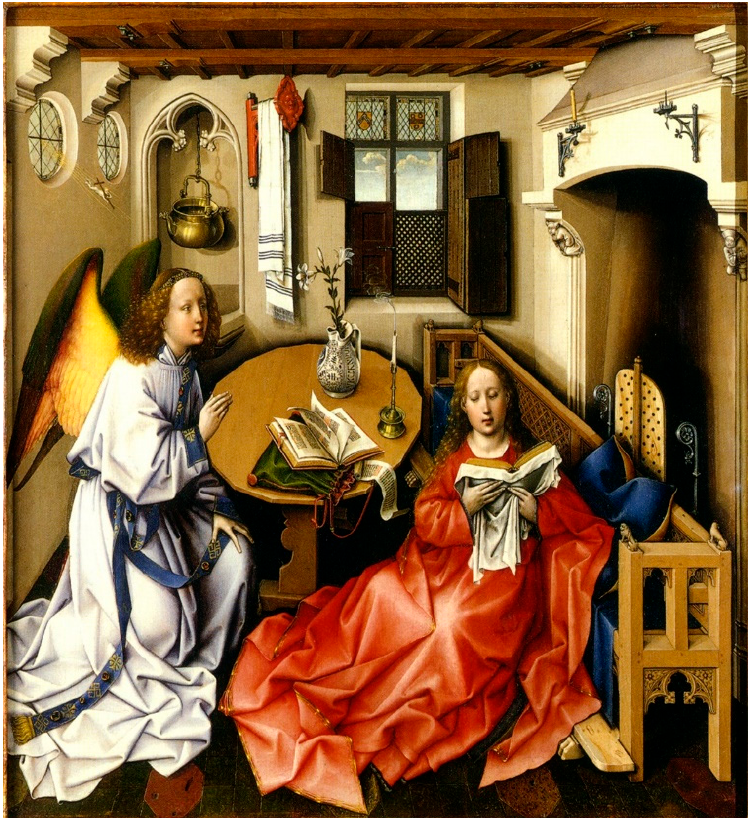
Figure 3. Robert Campin’s workshop, The Annunciation , central panel of the Mérode Triptych , c. 1427– 1432. The Metropolitan Museum of Art, New York. 1432. The Metropolitan Museum of Art, New